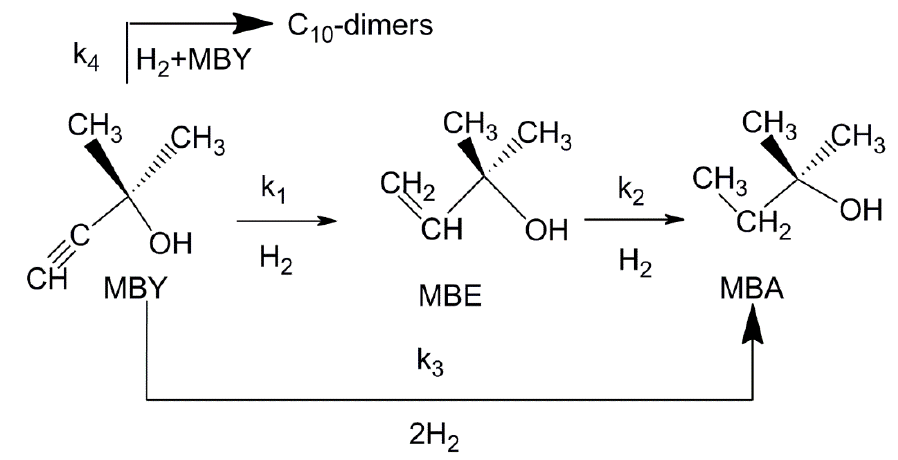
Figure S4: Dependences of the concentrations of MBY, MBE and MBA on the contact time after different pretreatments on PdZn/TiO 2 -a (A), PdZn/TiO 2 -b (B), PdZn/TiO 2 -c (C), PdZn/TiO 2 -d (D), points - experiment, lines - calculation by the Langmuir-Hinshelwood model. Reaction conditions: gas flow rate 6.0 mL / min, = 1 atm, T = 313 K, Figure S5: Dependences of the concentrations of MBY, MBE and MBA on the contact time after different pretreatments on PdZn/Ti 0.8 Zr 0.8 O 2 -a (A),